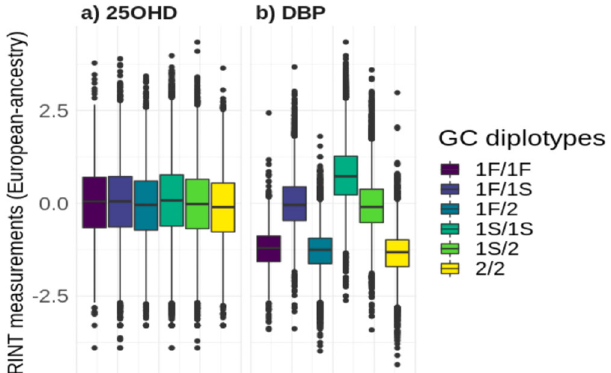
Fig.2|Distributionsoftransformed25-hydroxyvitaminD(25OHD)andvitamin D binding protein (DBP) by the six diplotypes, within the European ancestry subgroup. The colors represent the six diplotype combinations. The center lines show the medians; box limits indicate the 25th and 75th percentiles; whiskers extend1.5timestheinterquartilerangefromthe25thand75thpercentiles;outliers arerepresentedbydots.Thesamplesizesforthe1F/1F,1F/1S,1F/2,1S/1S,1S/2NS 2/2 diplotypes for a 25OHD are 1452, 10,986, 5262, 21,694, 20,644, and 4950 respectively;and b